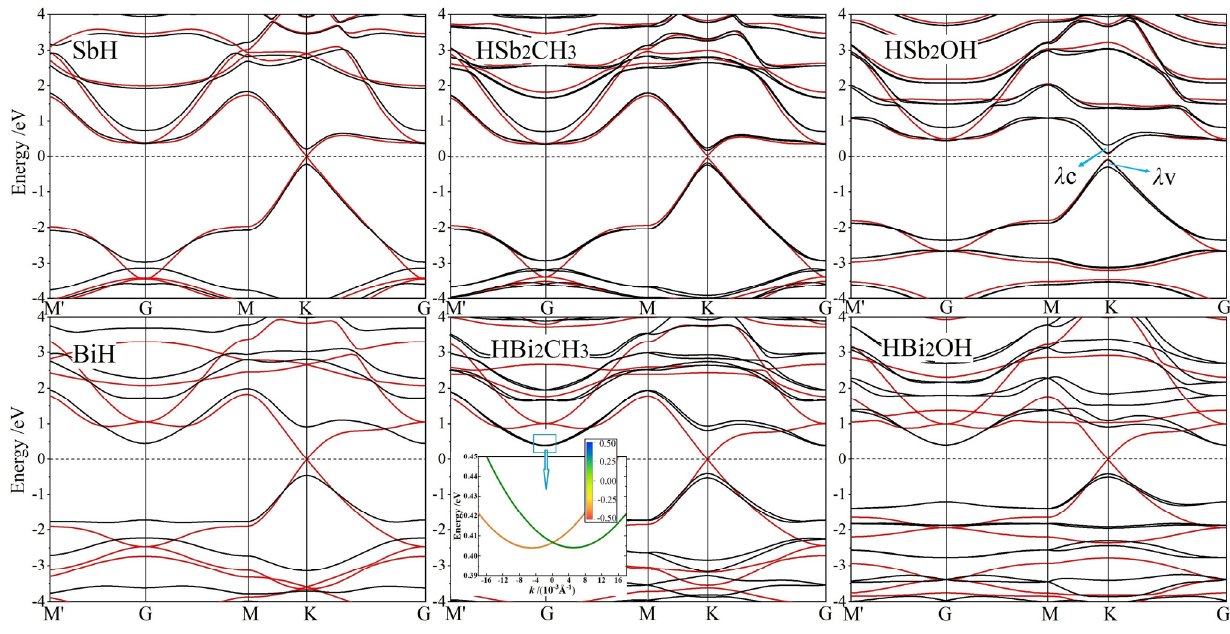
Figure 4. Band structures without SOC (red curves) and with SOC (black curves) of Janus Sb (top panels) and Bi (bottom panels) monolayers, and SbH and BiH monolayers with inversion symmetry are presented for comparison, in which Fermi level is referenced as energy zero (horizontal dash line). Table 2. Rashba spin-splitting R G of the highest valence band at G point, SOC-induced splitting λ v and λ c at K point for valence and conduction band-edges respectively, SOC-induced Dirac-cone splitting gaps at K point E D (K), global band-gaps E g (global) of Janus Sb and Bi monolayers compared with SbH and BiH